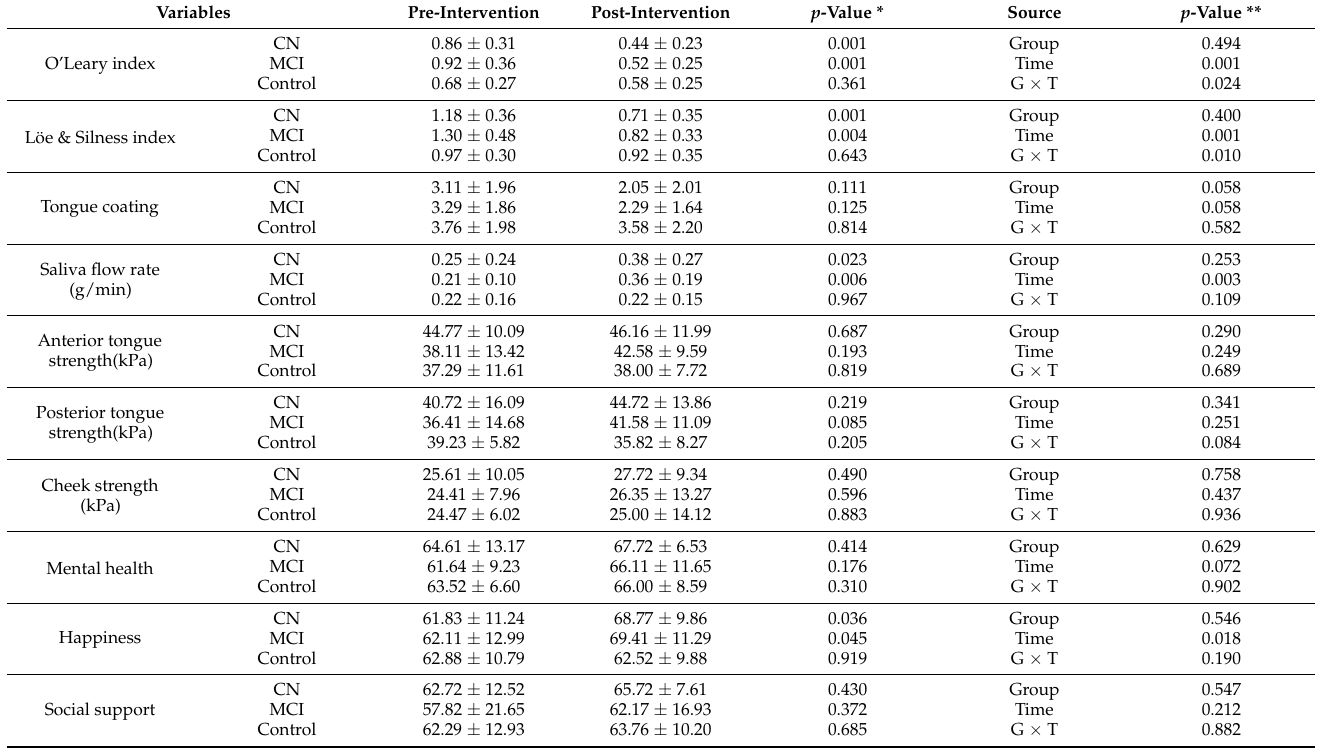
Table 4. Effects of the integrative program on oral and mental